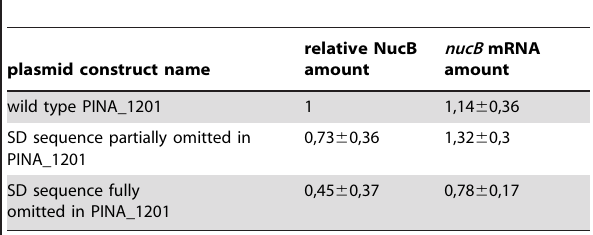
Table 2. NucB protein level in P. bryantii TC1-1 cultures harboring pRH3 constructs containing omitted SD sequence relative to the wild type upstream sequences.